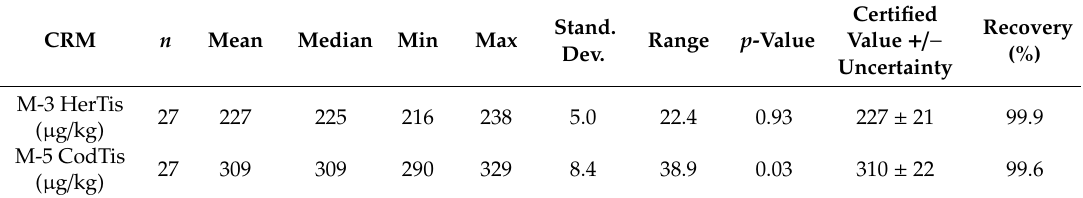
Table 1. Summary of the main statistics for the results of mercury content in both certificate reference materials ( n = 27) ( µ g /